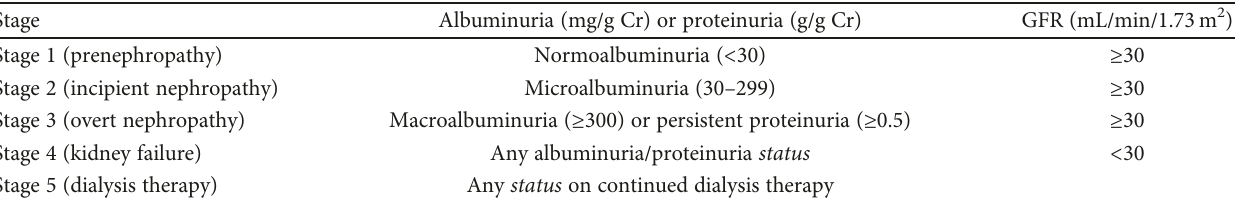
Table 1: Classi fi cation of diabetic nephropathy [12].